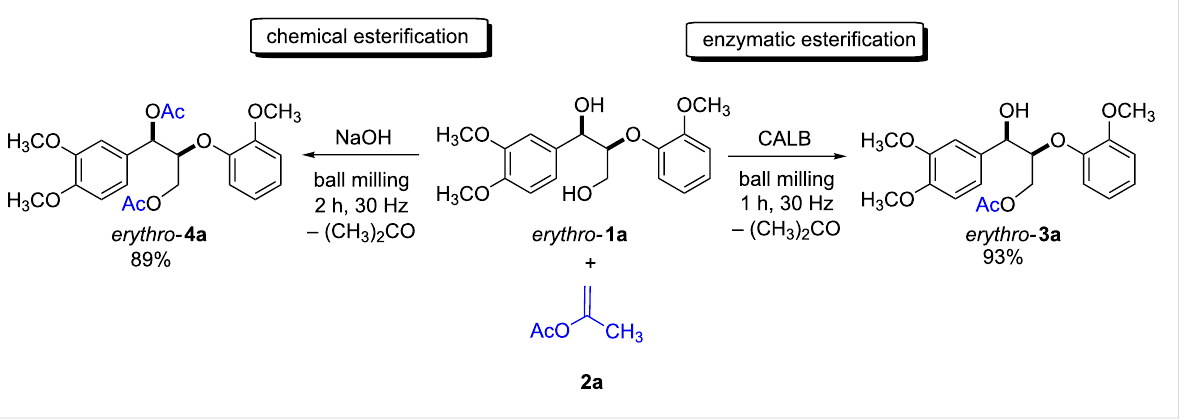
Scheme 2: Chemical and enzymatic esterification of erythro - 1a with isopropenyl acetate ( 2a ) in the ball mill. Reaction conditions: erythro - 1a (50 mg, 0.15 mmol), 2a (0.60 mmol), CALB (30 mg of immobilized enzyme) or NaOH (12 mg, 0.30 mmol), 10 mL ZrO 2 milling jar, 6 ZrO 2 milling balls (5 mm in